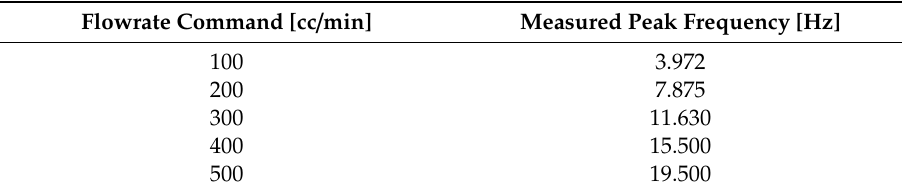
Figure 5. Fast Fourier transform (FFT) of flowrate; ( a ) 400 cc / min flowrate command; ( b ) 100 cc / min flowrate command. Table 1. Peak frequency of measured flowrate output.